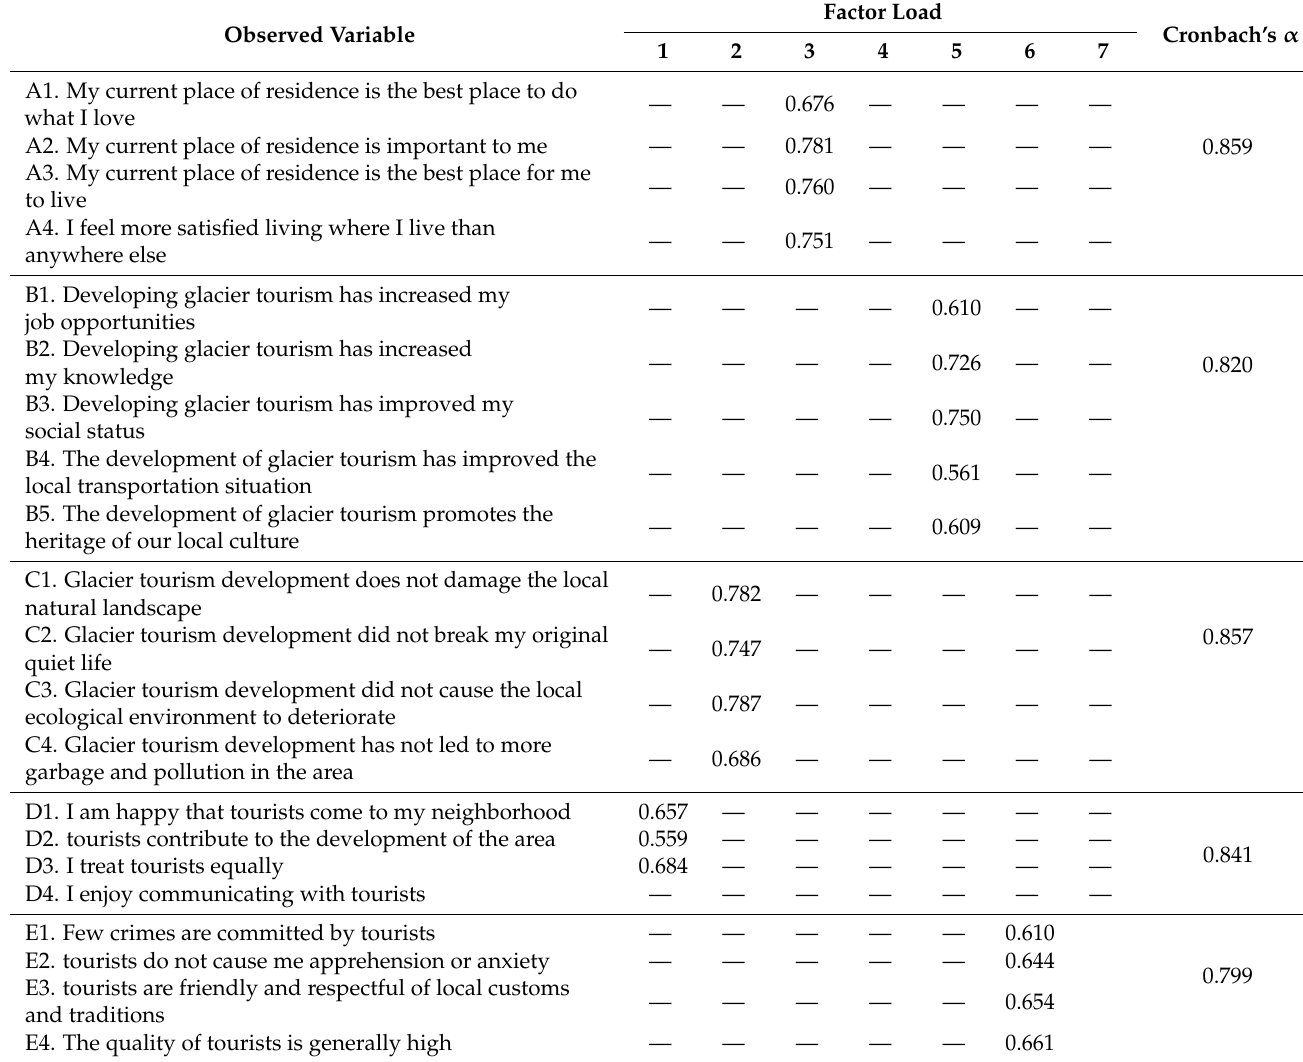
Table A2. Resident perception and attitude evaluation index